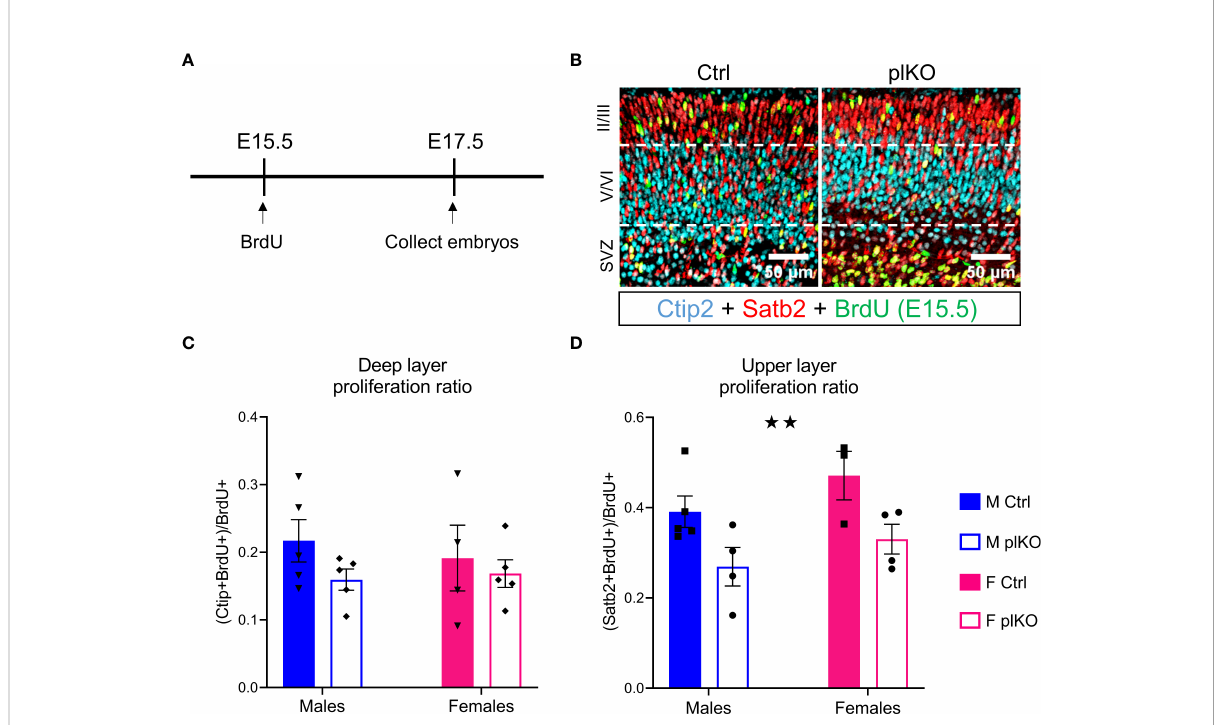
FIGURE 6 Effect of placental ALLO insuf fi ciency on cortical neurogenesis. (A) Overview of the experiments: BrdU was injected at E15.5, and embryos were euthanized at E17.5. (B) Determination of the localization of proliferating E15.5 cells (BrdU, green) by co-staining with Satb2 (red) upper layer principal cell marker and Ctip2 (cyan) lower layer principal cell marker. (C) Quanti fi cation of (B) shows that while deeper layers were unaltered, (D) fewer E15.5 born cells localized to the upper layers of the cortical plate. n = 5 M Ctrl, 4-5 F Ctrl, 3-4 M plKO, 4-5 F plKO. Data presented as mean ± SEM. Two-way sex by genotype ANOVA with Sidak ’ s post-hoc comparison test. Main effect of genotype: ★★ p < 0.01. Ctip2, COUP-TF- interacting protein 2; F, female; M, male; Satb2, Special AT-rich sequence-binding protein 2. SVZ, sub-ventricular